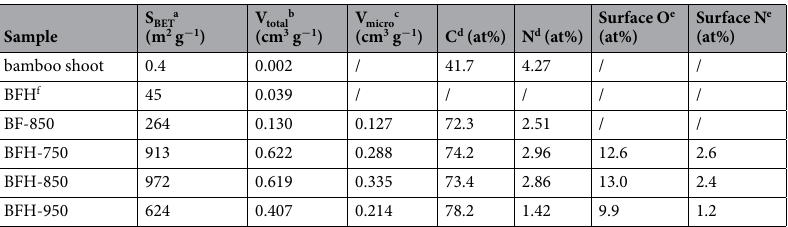
Table 1. Textural properties and chemical composition of carbon materials. a BET surface area calculated from the linear part of the BET plot (P/P 0 = 0.1-0.2). b Total pore volume, taken from the volume of N 2 adsorbed at P/P 0 = 0.99. c t-plot micropore volume. d Calculated from the results of elemental analysis. e Calculated from the results of XPS spectra. f the hydrothermal